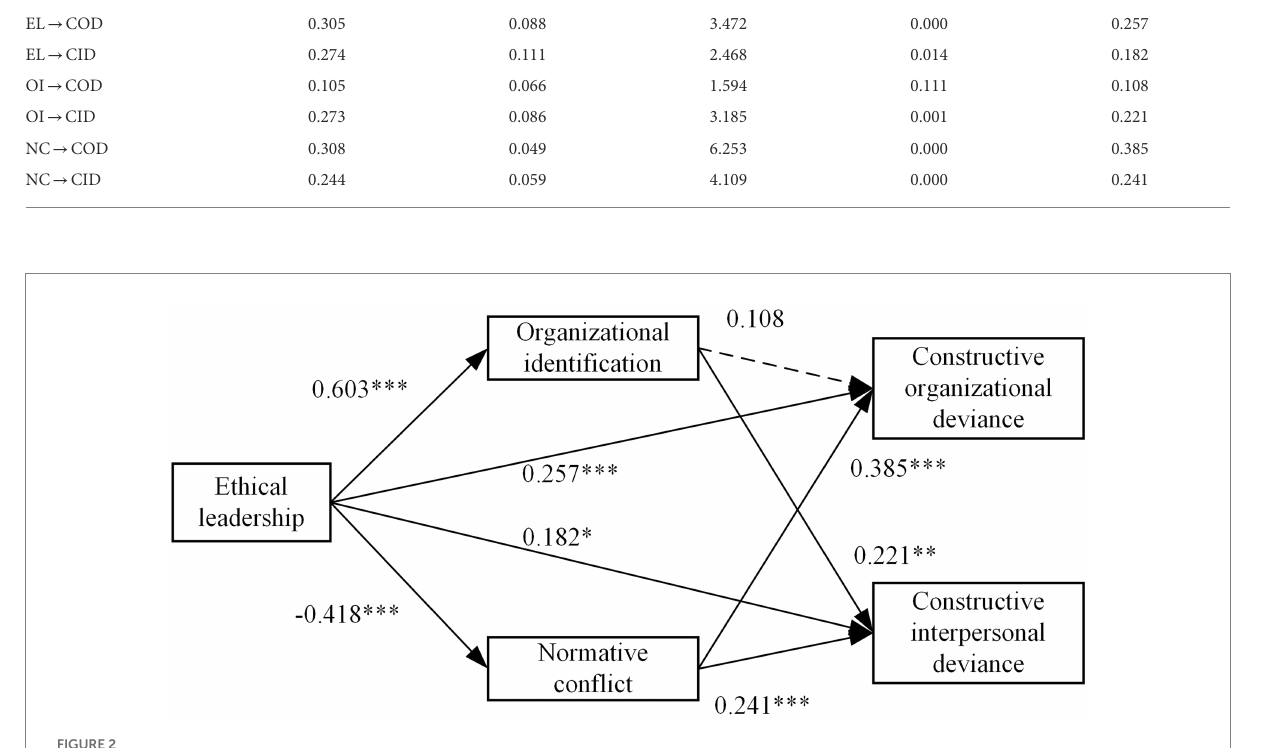
FIGURE 2 Path coefficients.